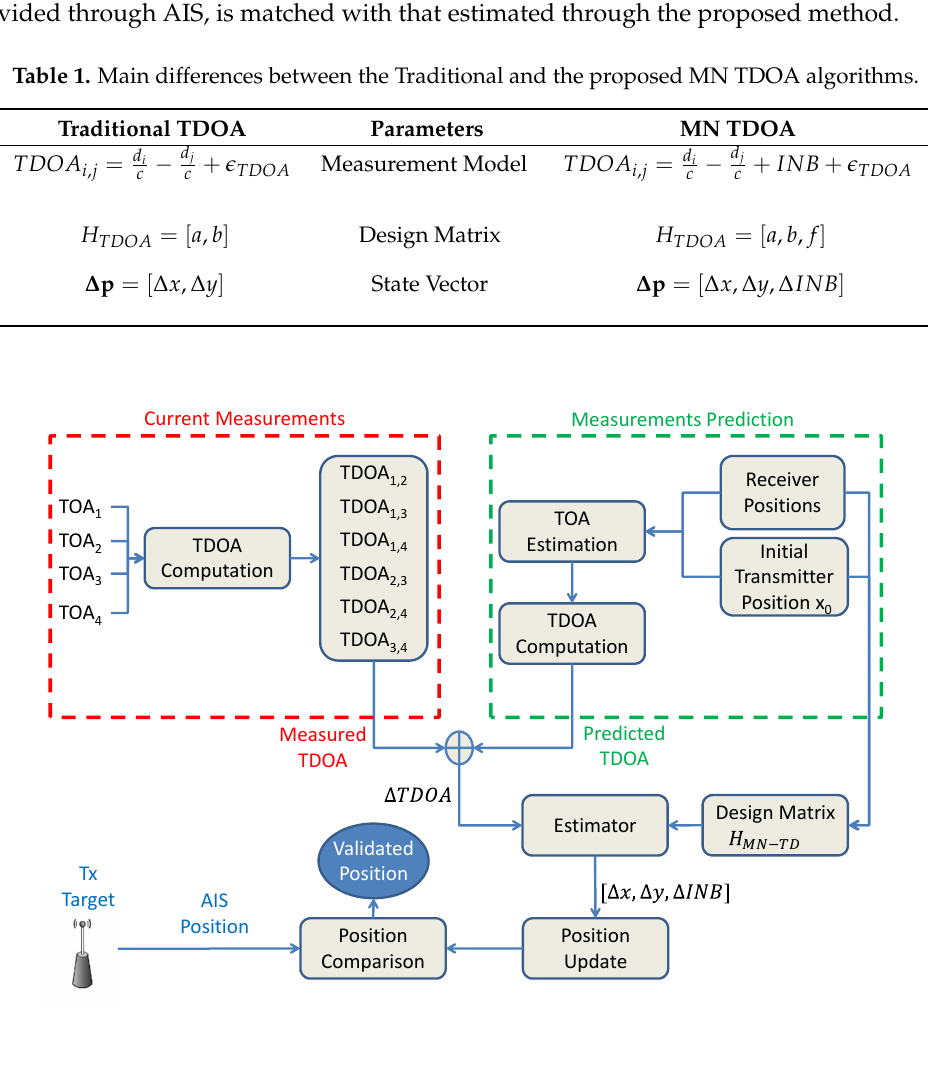
Figure 3. Flow chart of the proposed MN TDOA algorithm applied to AIS position validation. The novelty is the automatic compensation of the INB (through the estimation of the unknowns ∆ INBs ), which allows using different networks of not-synchronised